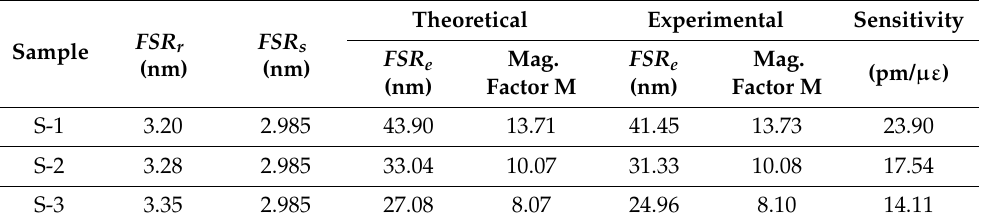
Figure 9. Sensitivity and linear correlation function of S-1, and inset exhibits spectral evolution of envelope dip data.